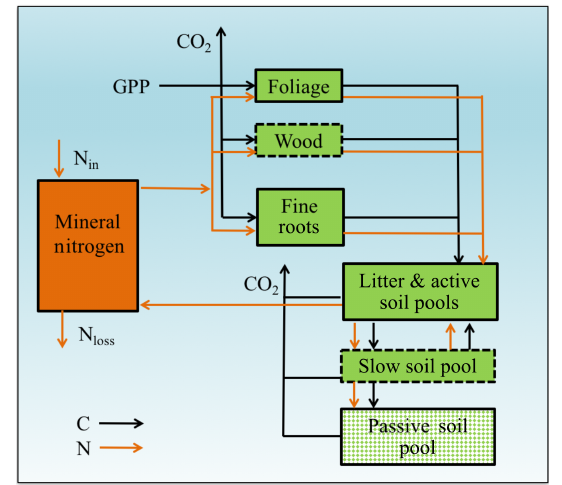
Figure 2. Framework of the Generic Decomposition And Yield (G’DAY) model. Boxes represent pools; arrowed lines represent fluxes. Boxes with dotted boundaries are M-term recycling pools (wood and slow soil). Box filled with diamonds is the L-term recy- cling pool (passive